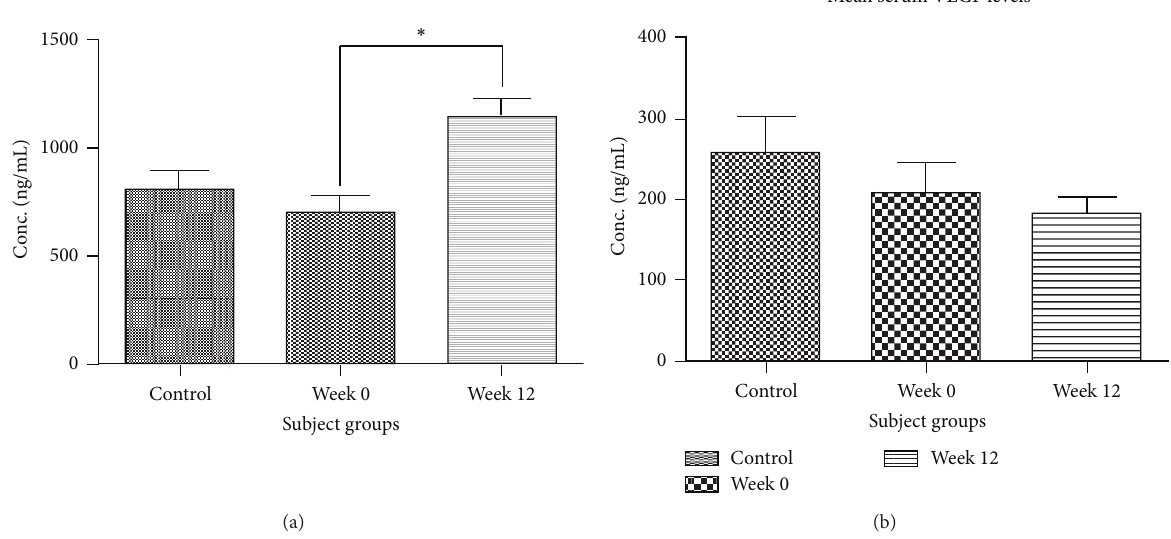
Figure 1: Serum neurotrophin levels. Grouped analysis of serum BDNF levels (a) revealed a greater mean BDNF level of the FEP patient group at week 12 compared to week 0. There was no overall difference in VEGF levels between the three subject groups (b). ∗ One-way ANOVA followed by post hoc t -test 𝑃 < 0.05